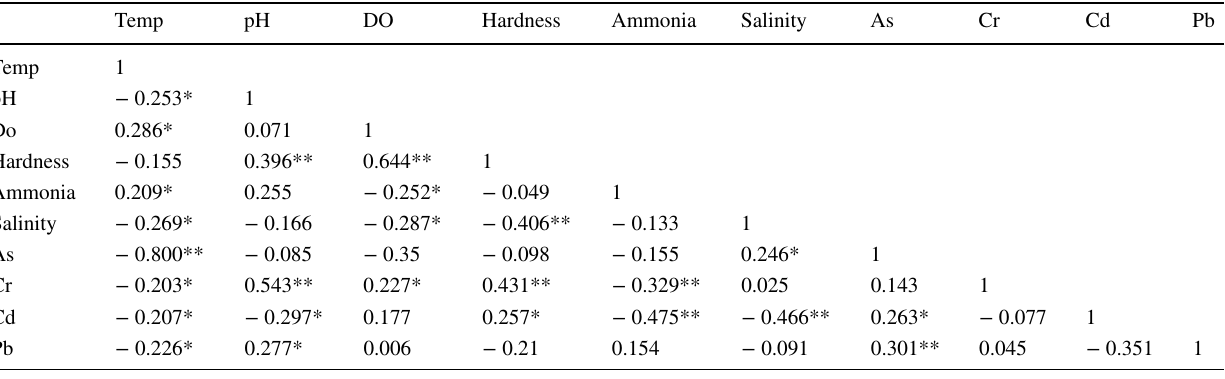
Table 3 The Spearman order rank correlation coefficient among the physicochemical parameters of heavy metals and surface water in the Meghna River Estuary, Noakhali, Bangladesh